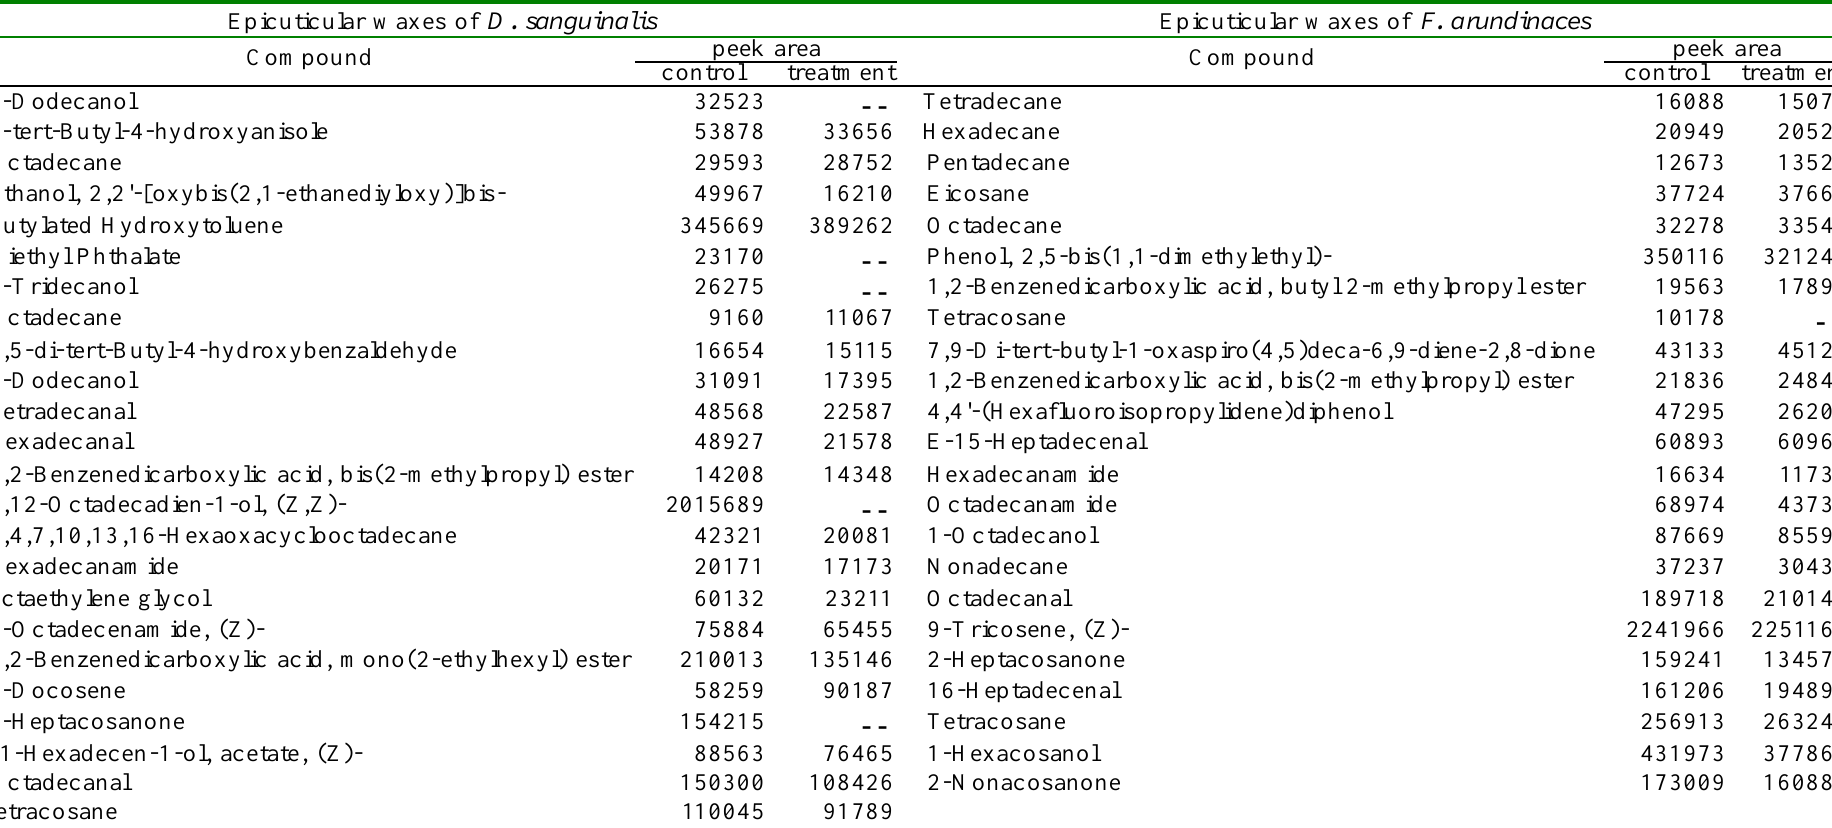
Table 2. The components analysis of epicuticular waxes incubated with crude esterase solution from extracellular conidia of C. eragrostidis Epicuticular w axes of D. sanguinalis Epicuticular w axes of F.